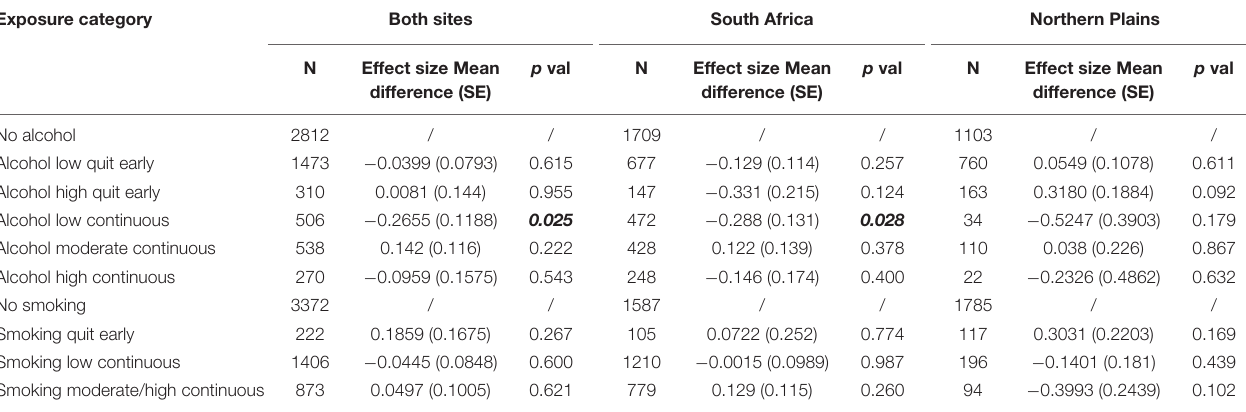
TABLE 11 | Linear regression results from alcohol and smoking exposure predicting fetal movement/HR cross-correlation Lag.